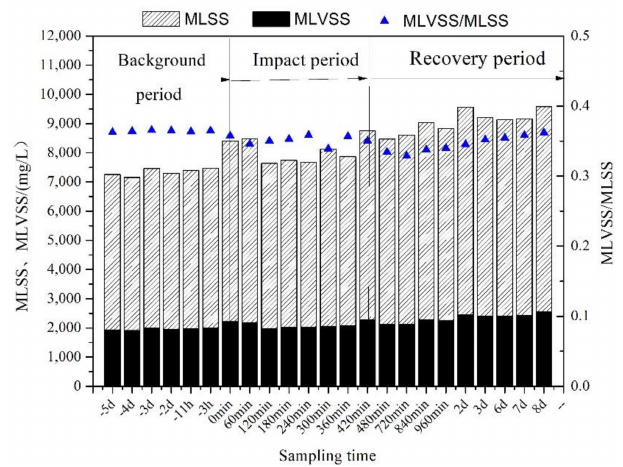
Figure 6. The variation of mixed liquor MLVSS/MLSS during